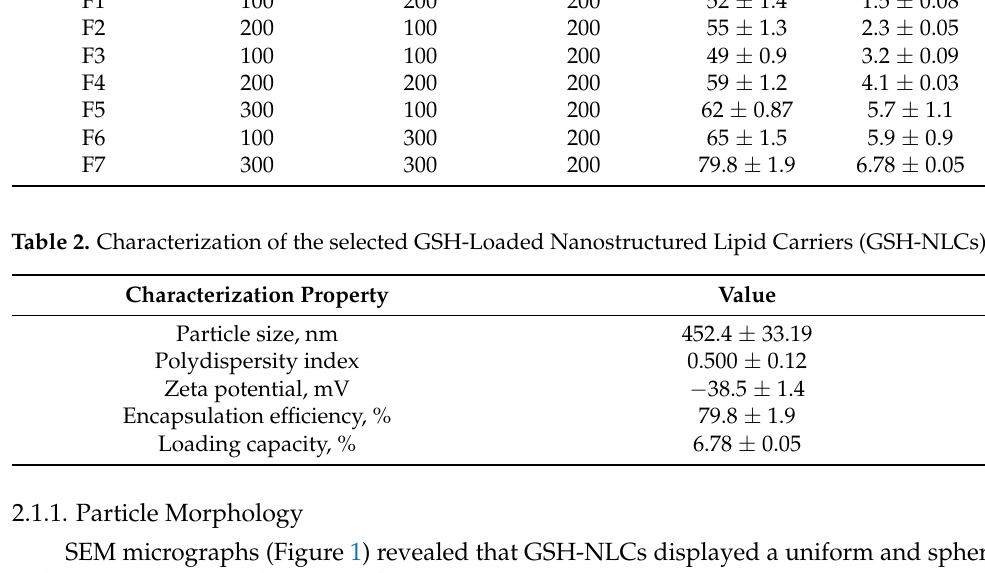
Table 1. Composition of glutathione-loaded nanostructure lipid carrier. Formulation